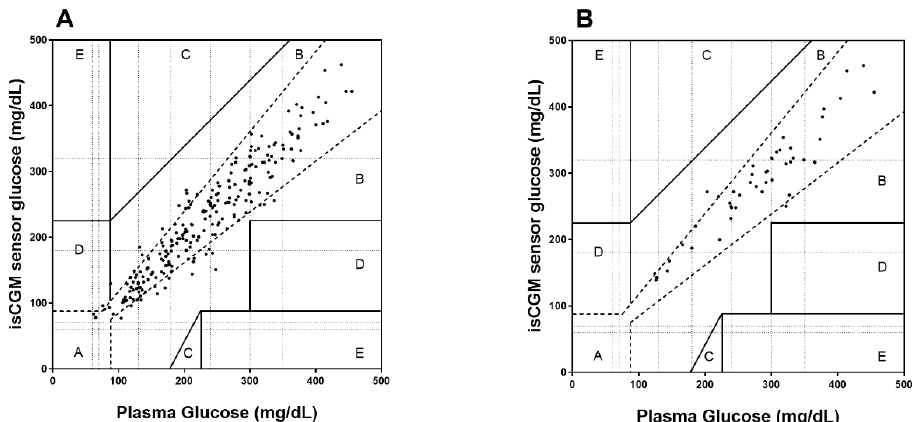
Figure 1. Clarke Error Grid (CEG) analysis for the assessment of isCGM accuracy for overall data ( A ), during low RCPG ( B ), moderate RCPG ( C ), and high RCPG ( D ) with respect to clinical